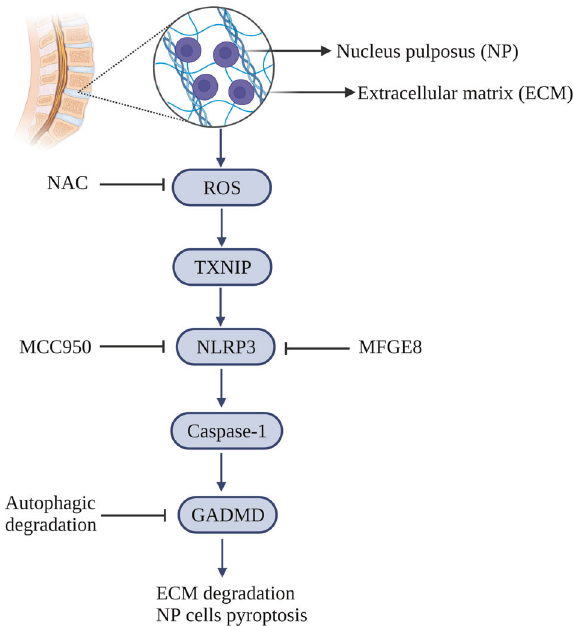
Fig. 6 Pyroptosis and IVDD: The classical pyroptotic pathway can cause nucleus pulposus cell death and extracellular matrix degradation. Inhibition of targets related to the pyroptotic pathway can reduce cytolethality.